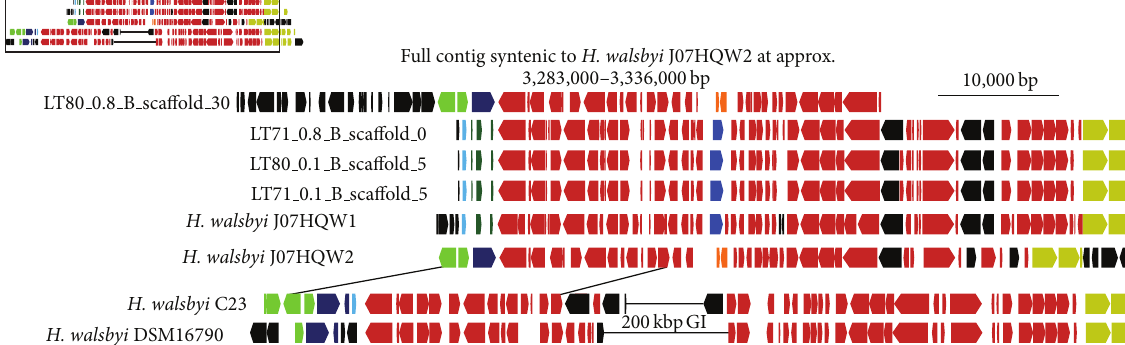
Figure2: Inset:agenemap oftheregion spanning1,600,000–1,660,000 bpalong the H. walsbyi J07HQW1 genome, thecorrespondingregions in the other H. walsbyi genomes , and the environmental contigs. Full image: an expanded view of the region denoted in the inset. Syntenic regions are marked by matching colors. Environmental contigs use a long form identification number (see Figure 1 caption). The regions represented on the gene map from each genome are as follows: J07HQW1, 1,600,465–1,660,398 bp; J07HQW2, 3,299,582–3,359,276 bp; C23, 1,240,000–1,270,000 bp and 1,530,000–1,490,000 bp; DSM16790, 1,240,690–1,270,000 bp and 1,510,000–1,470,000 bp.